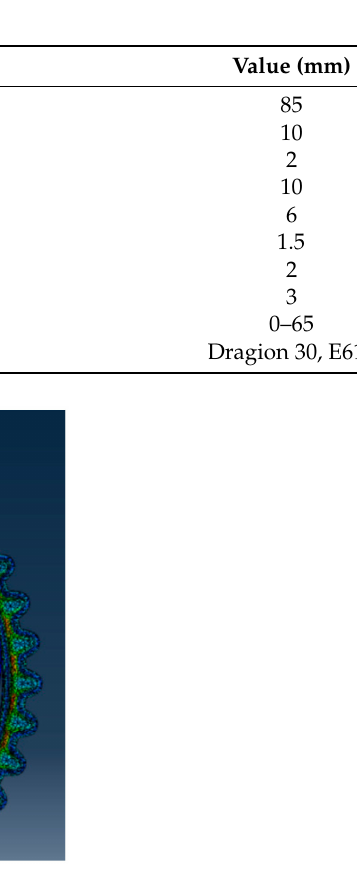
Figure 13. Soft gripper grasping apple